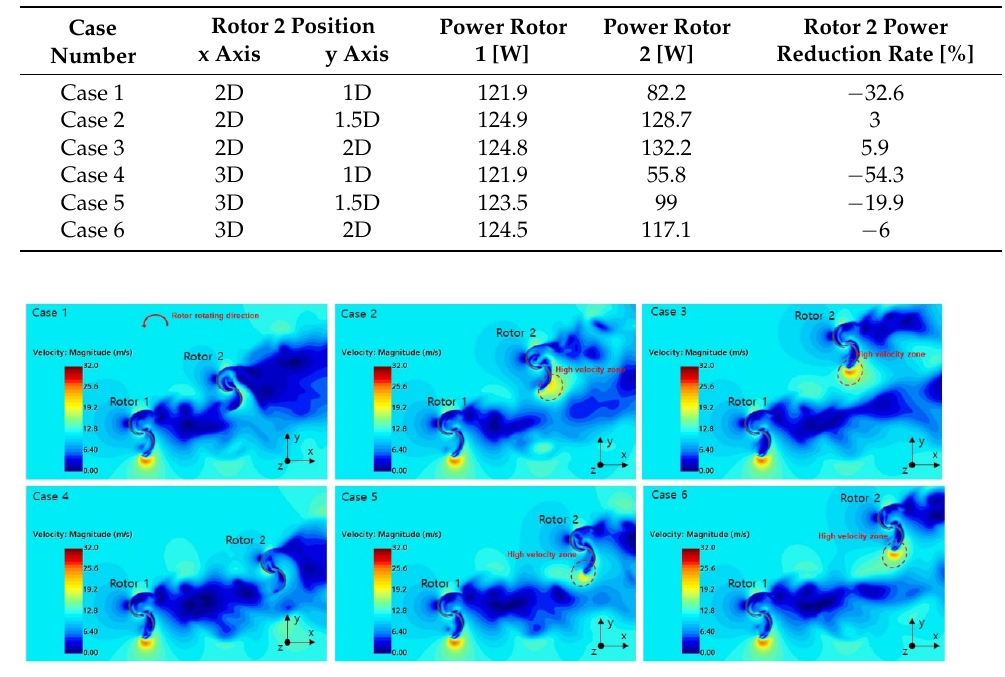
Figure 13. Analysis conditions for rotor spacing examination and comparison of power per rotor rotation: ( a ) Rotor arrangement cases, ( b ) Power per rotor rotation. Table 5. Rotor power according to downstream rotor position.